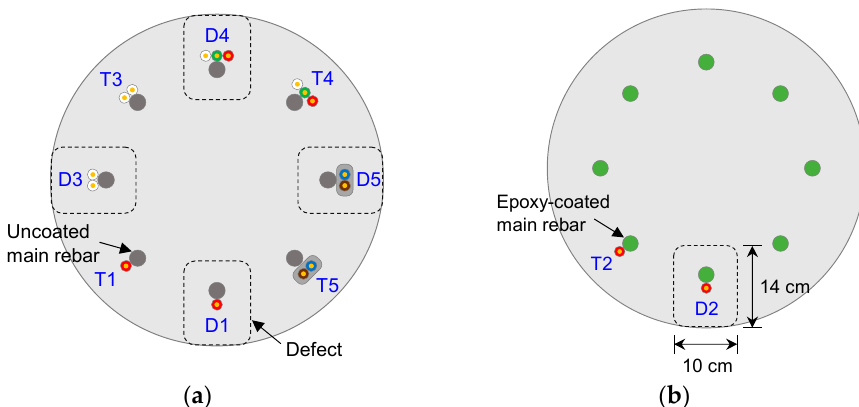
Figure 5. Plan view of model piles constructed with: ( a ) an uncoated reinforcement cage and ( b ) an epoxy-coated reinforcement cage. Table 1. Dielectric constants measured using a time domain reflectometer (TDR) probe without insulation and e ff ective dielectric constants measured using TDR probes with polyvinyl chloride (PVC) insulation and transmission lines (T1 and D1–T5 and